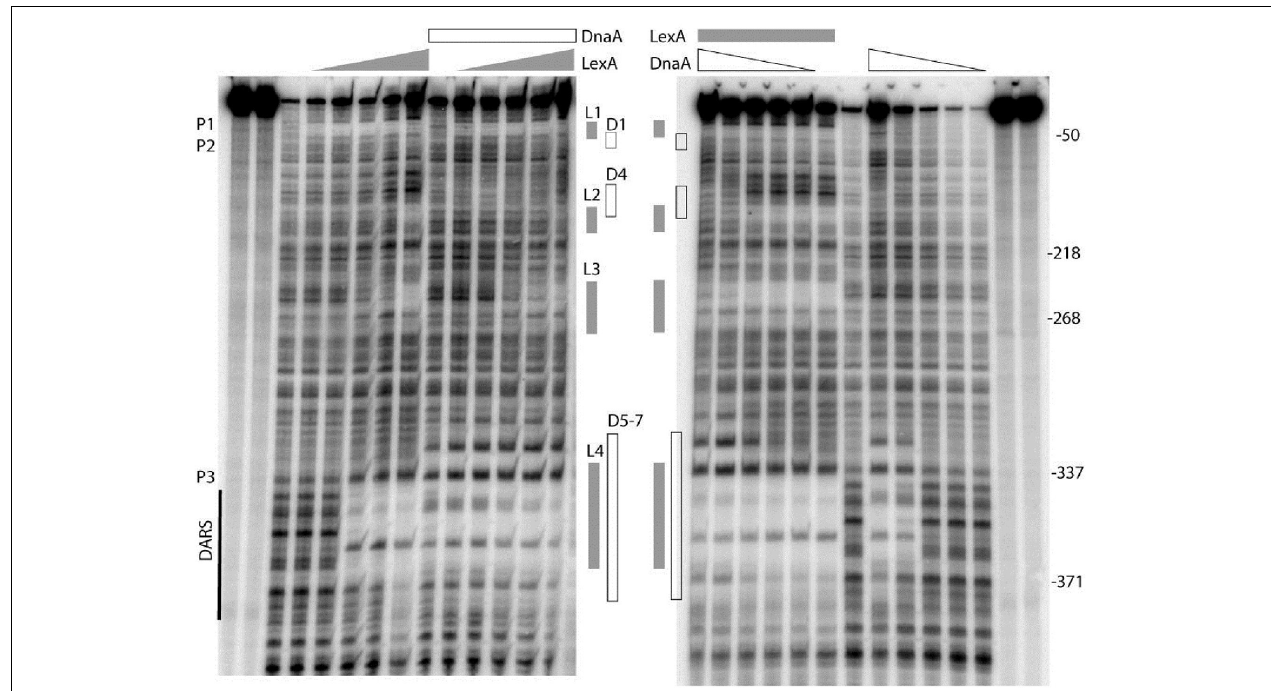
FIGURE 3 | DnaA and LexA protect the uvrB promoter region in either competitive or independent manner. The uvrB promoter fragment (–513 to +12 relative to the transcription starting site of uvrB p1) was generated by PCR using the upstream oligonucleotide labeled with gamma 32 p-ATP by T4 kinase at the 5 (cid:48) end. The labeled DNA was either incubated at 37 ◦ C with increasing concentrations (50, 100, 200, 300, and 600 nM) of LexA (left) or ATP-DnaA (right) protein. After 10 min incubation of either the ATP-DnaA or the LexA protein with the labeled DNA, the sample had the other protein. The DNA was cleaved by DNase I for 20–30 s after 10 min of incubation with the second protein. The reaction was stopped by addition of an equal volume of formamide gel loading buffer and placed on ice. The gray boxes show the sites protected by the LexA protein. The white boxes correspond to the protection by ATP-DnaA. The protected DnaA-boxes are indicated as D, the LexA-boxes are as L. The DARS site is also shown. P1, P2, and P3 represent promoter uvrB p1, uvrB p2, uvrB p3, respectively. The right and left most two lanes are for